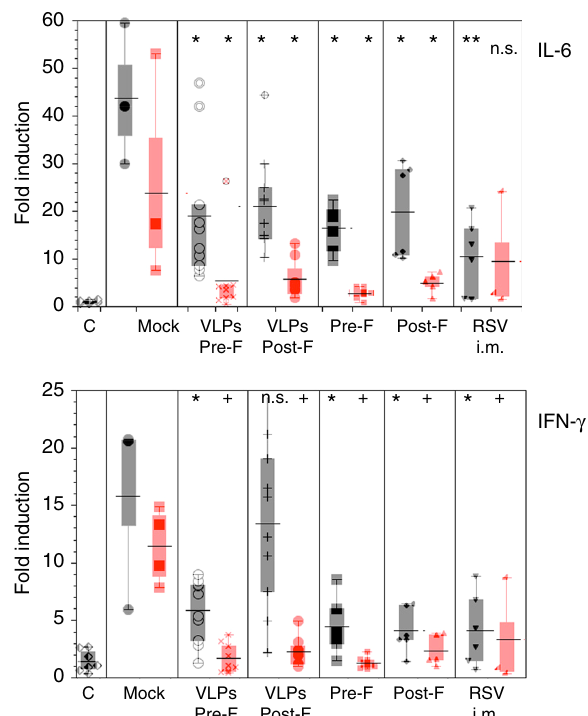
Fig. 7 Lung cytokine expression. Expression of mRNA for the cytokines IL-6 and IFN- γ in the lungs of RSV-infected litters born to naive (black symbols) or RSV-primed (red symbols) dams vaccinated as indicated ( n = 3 – 10). Control (C) represents animals that were naive and not infected (used as baseline for mRNA expression). Symbols represent the mean of individual litters. Bar across represent the mean ± s.e.m. of a group. Boxes represent the boundaries of the quartiles. Comparison of the expression between the respective mock-vaccinated group and VLPs or RSV-i.m.-vaccinated groups was assessed by one-way ANOVA followed by Tukey post hoc test. + p